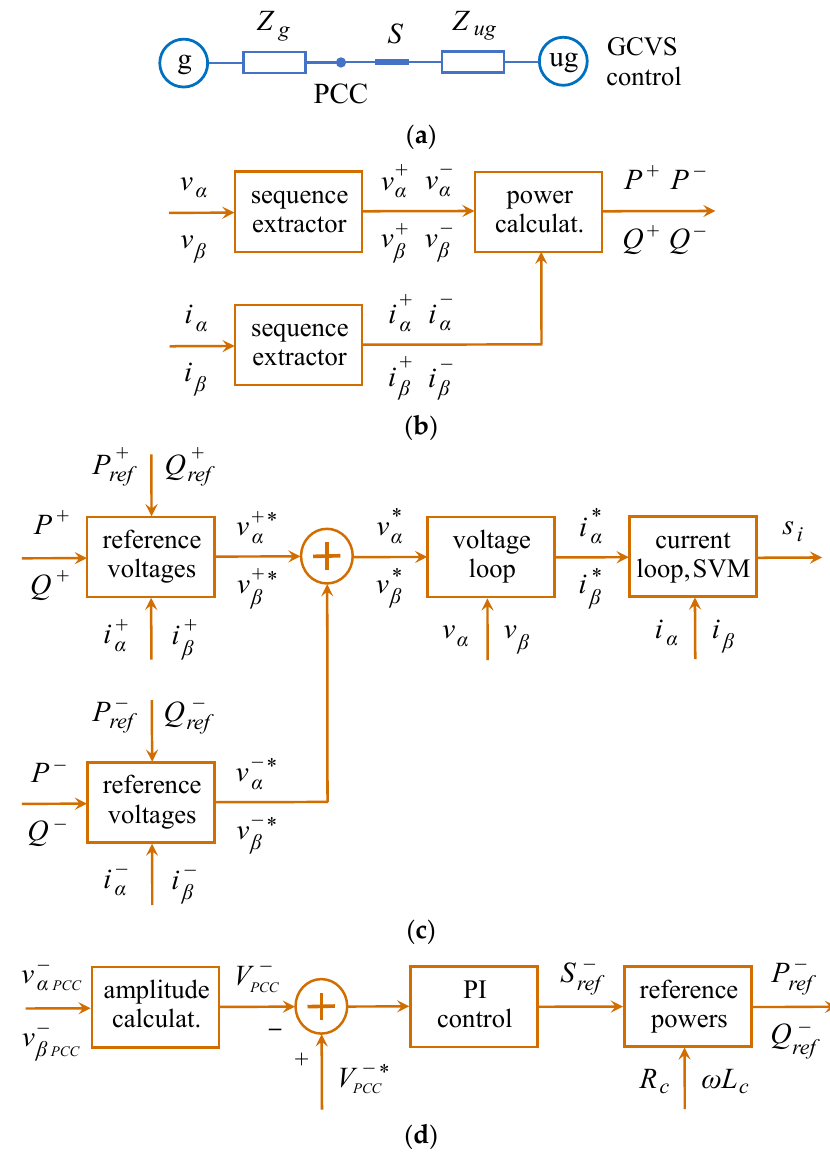
Figure 5. GCVS control scheme: ( a ) diagram of the power system; ( b ) calculation of positive and negative sequence active and reactive powers; ( c ) generation of reference voltages, voltage and current control loops and SVM; ( d ) generation of negative sequence active and reactive powers.